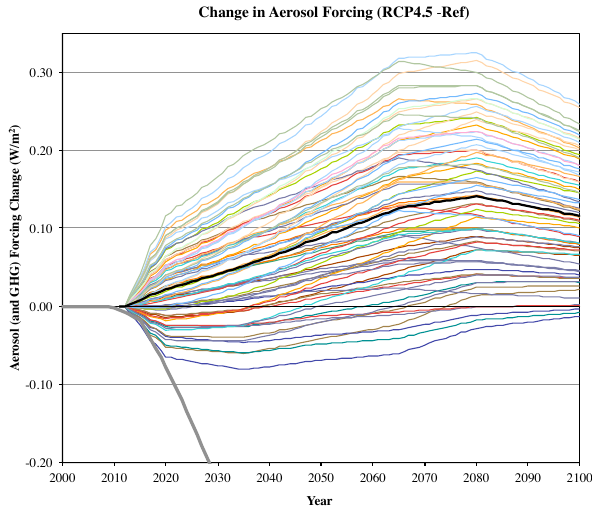
Fig. 5. Total aerosol forcing change between the reference and RCP4.5 climate policy scenario for the suite of aerosol forcing cases (central forcing assumptions, thick black line). A positive value in- dicates a positive forcing change (e.g., warming) under the RCP4.5 climate policy scenario as compared to the reference case. Refer- ence case aerosol emissions were assumed through 2012. The thick grey line shows the change in greenhouse gas